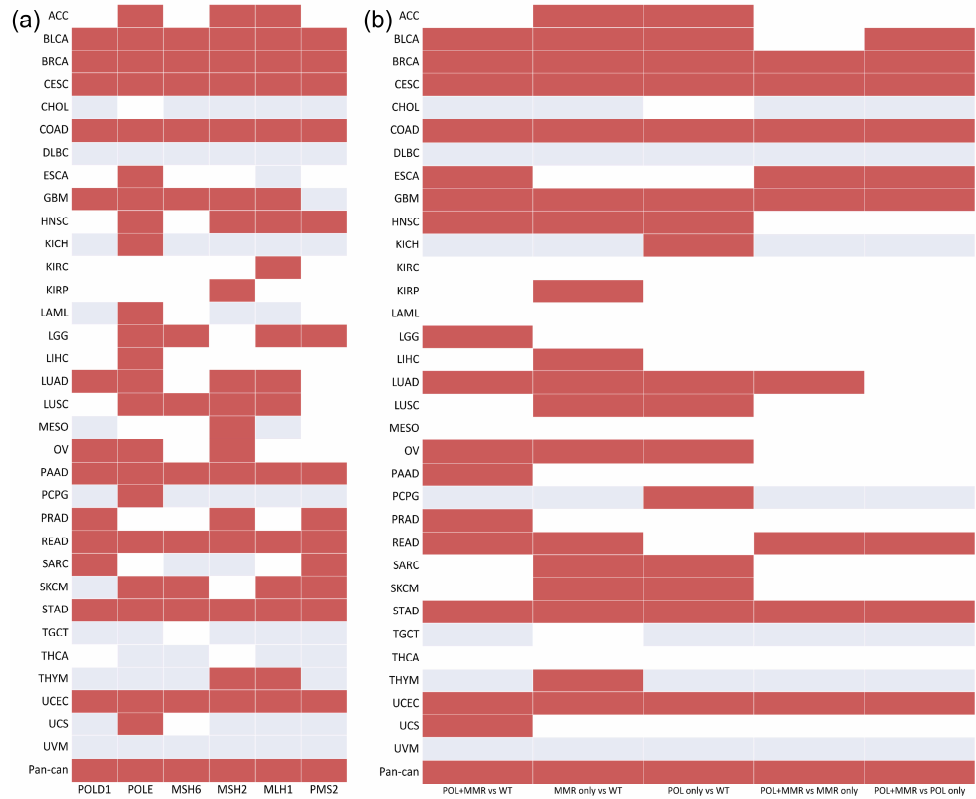
Figure 1. The association between TMB and the mutation status of the MMR and POL genes/gene sets in 33 cancer types and pan-cancer: ( a ) MMR and POL genes; ( b ) MMR and POL gene sets. Red indicates that the mutation status of the specific gene/gene set is significantly associated with high TMB. White indicates that mutation in the specific gene/gene set has no significant association with high TMB. Gray indicates that there is no mutation in this specific gene/gene set.